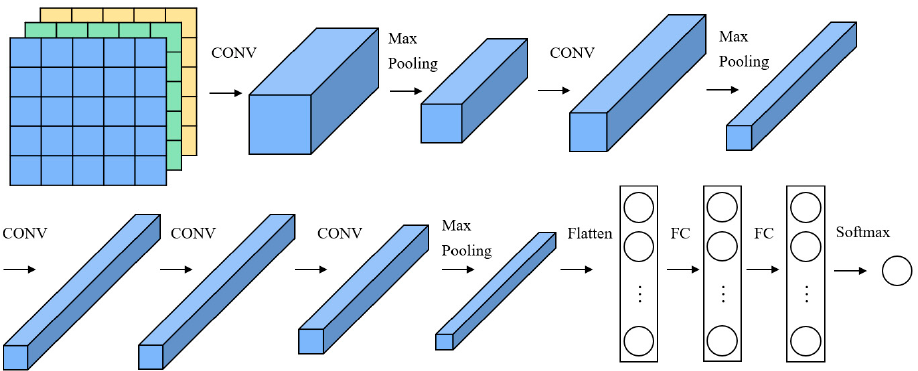
Figure 3. Schematic diagram of the AlexNet structure.